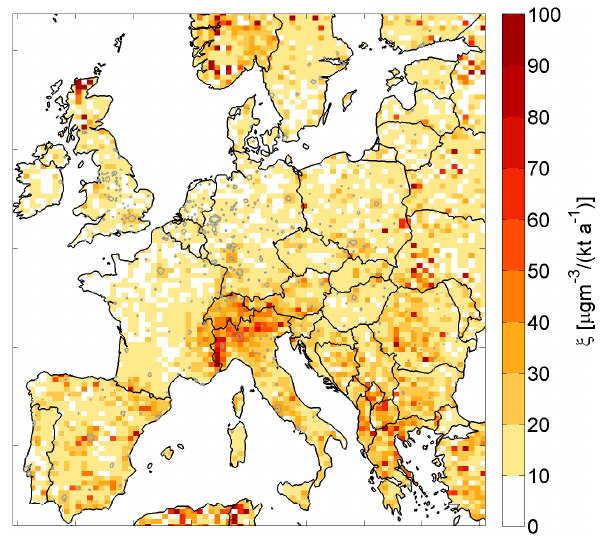
Fig. 2. Regression coefficient ξ relating NO x emissions to concen- tration increments in